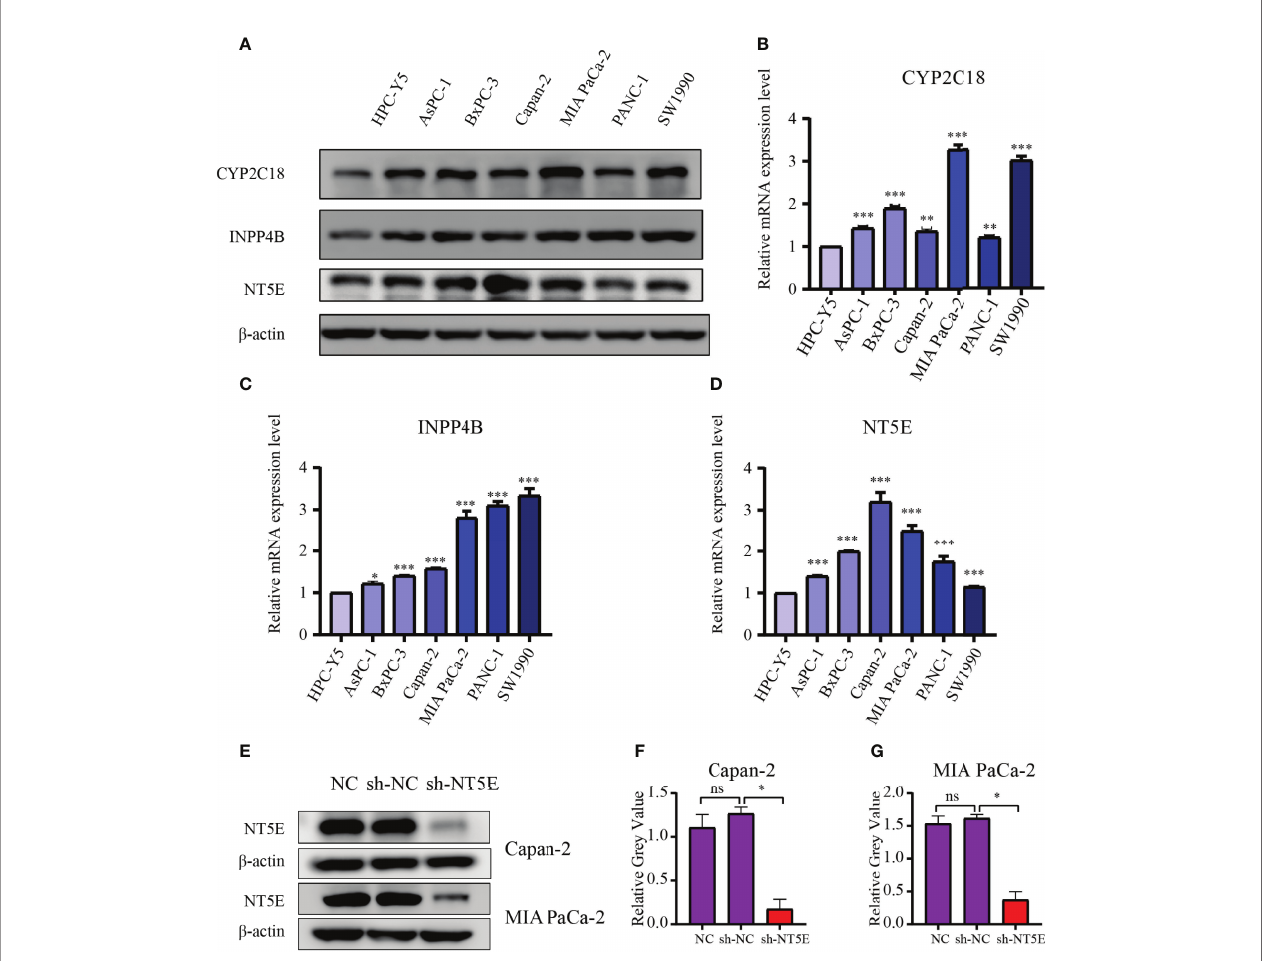
FIGURE 13 | Validation of the 3-MRGs levels via WB and qRT-PCR. (A) The protein levels of the three MRGs in six PC cell lines and pancreatic epithelial cells. (B – D) The mRNA expression of the three MRGs in six PC cell lines and pancreatic epithelial cells. (E – G) Con fi rmation of NT5E knockdown ef fi ciency by WB. * p < 0.05, ** p < 0.01, *** p < 0.001, ns, not signi fi